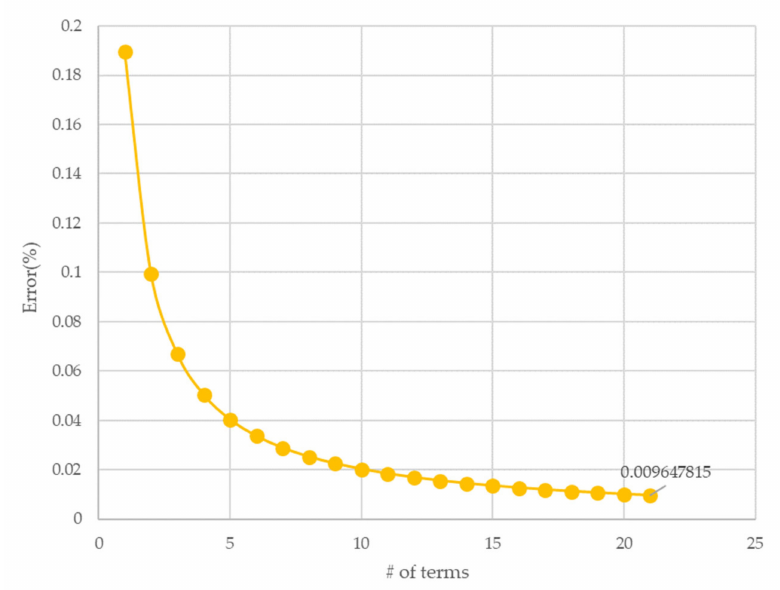
Figure 3. Number of terms versus error in Equation (2) at the initial